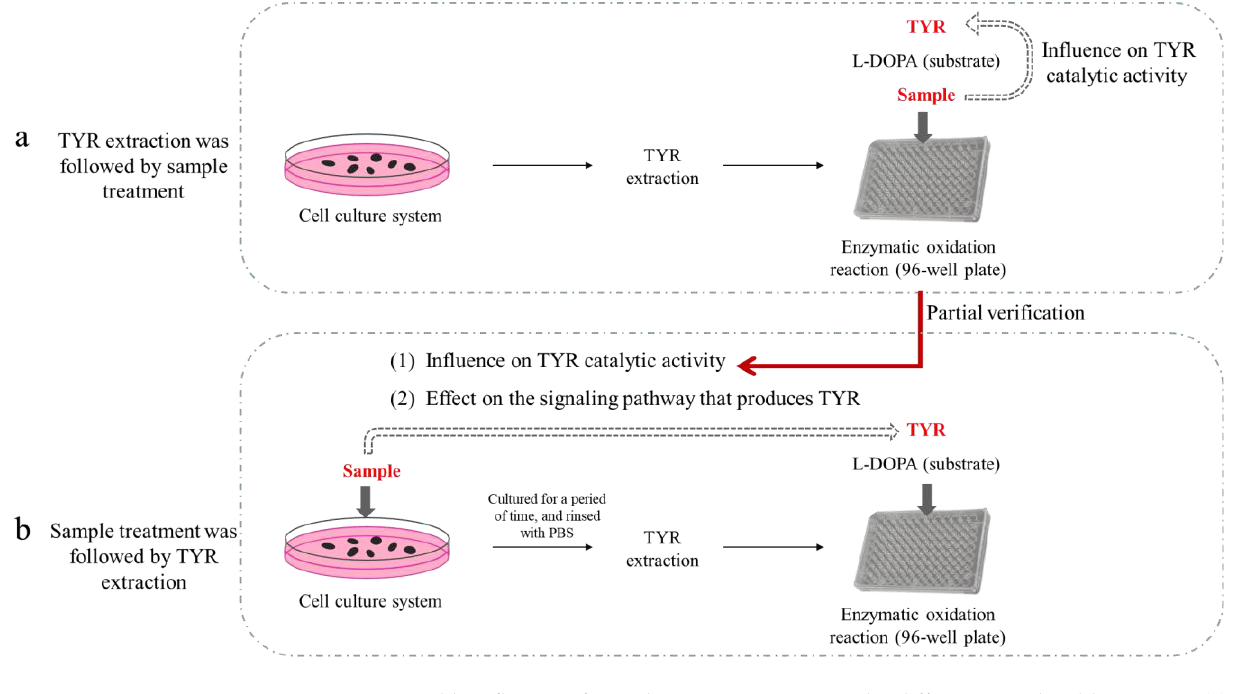
Figure 3. Possible influence of samples on TYR activity under different sample addition time. ( a ) TYR extraction being followed by sample treatment; ( b ) Sample treatment being follow by TYR extraction.